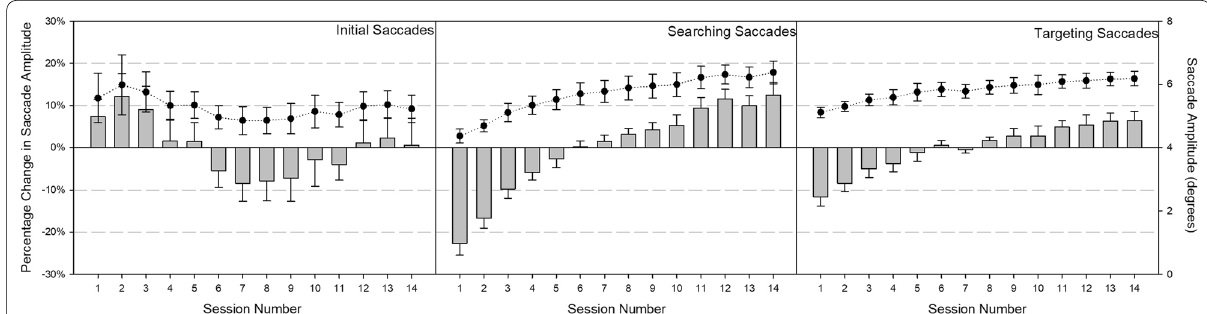
Fig. 11 Raw saccade amplitudes (circles) and percent change in saccade amplitudes (bars) across sessions for initial saccades (left panel), searching saccades (middle panel), and targeting saccades (right panel). Error bars reflect